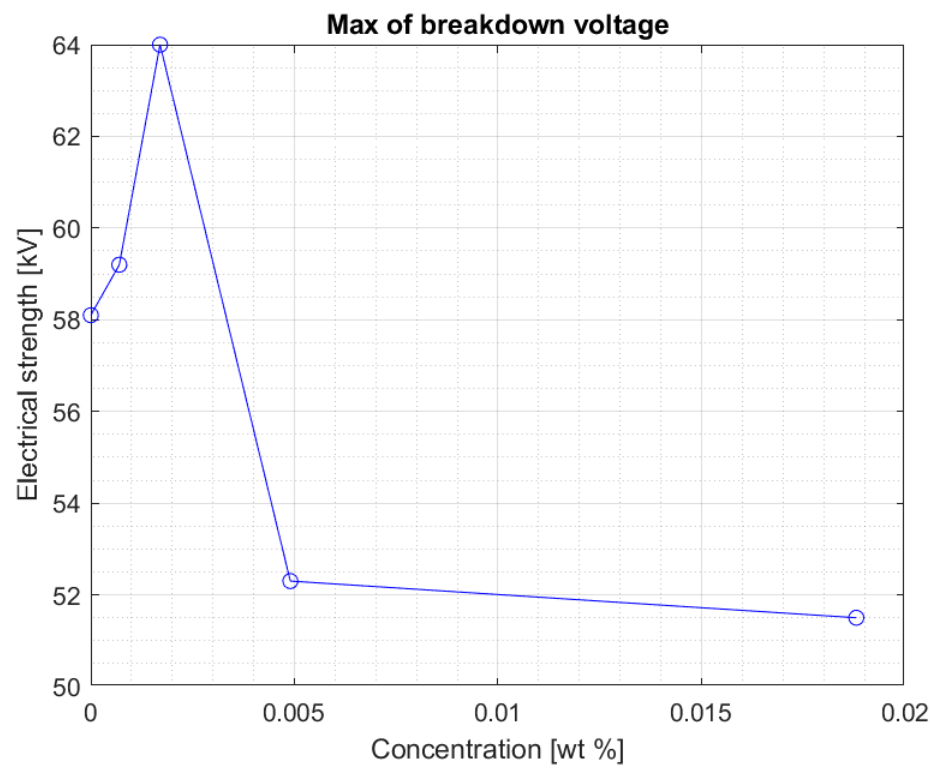
Figure 6. Maximum breakdown voltage values achieved for different nanoparticle concentration in the doped ester seven weeks after mixing.